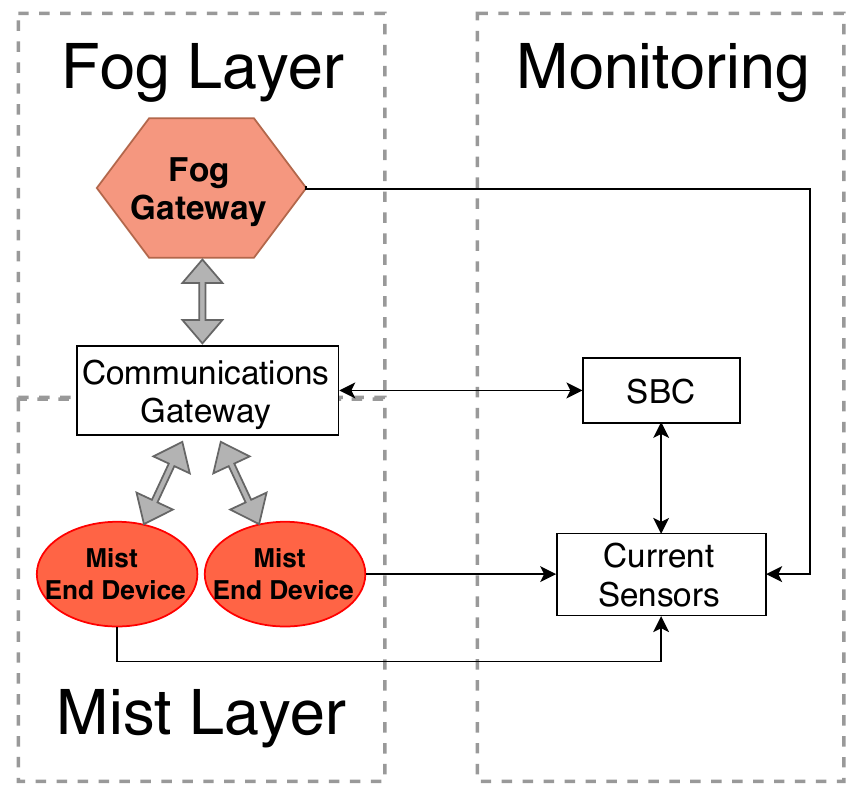
Figure 2. Testbed